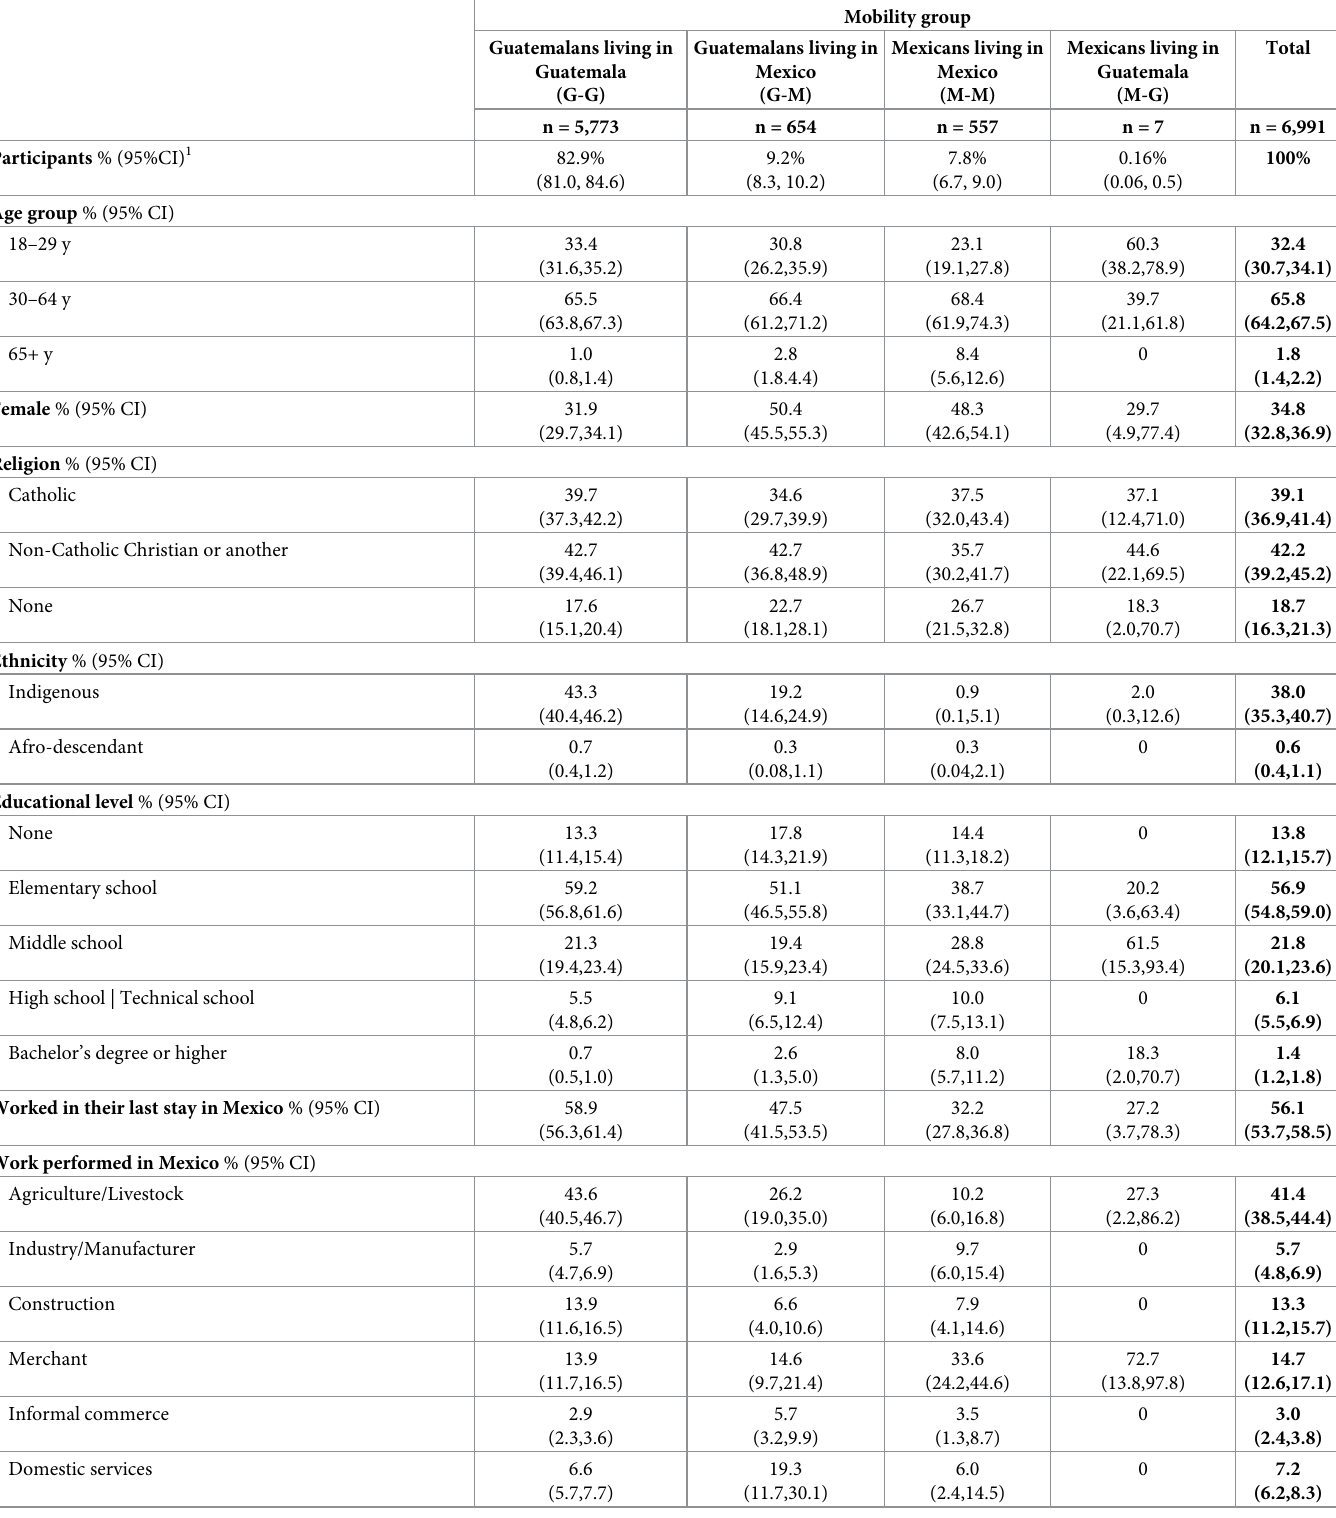
Table 1. Sociodemographic characteristics of survey